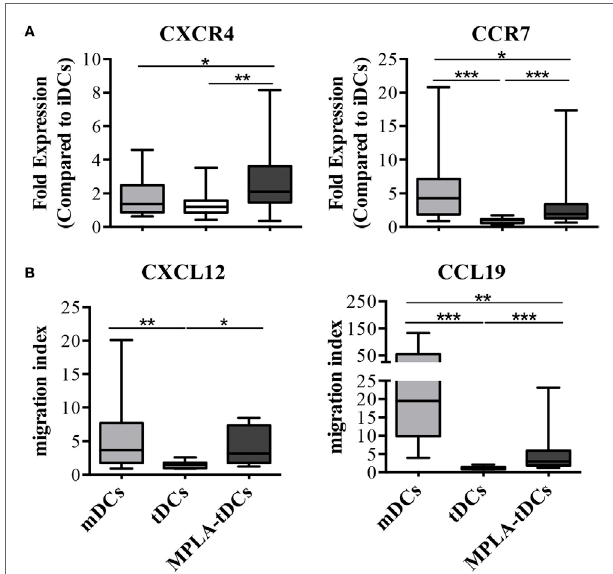
FigUre 3 | MPla-tDcs from rheumatoid arthritis patients display the capacity to migrate toward ccr7 and cXcr4 ligands . After 5 days of culture, the migratory capacity of MPLA-tDC ( dark gray ), tDCs ( white ) and mDCs ( light gray ) from rheumatoid arthritis (RA) patients was studied in vitro . (a) The percentage of CD11c + DCs expressing CXCR4 or CCR7 was determined by flow cytometry ( n = 15). Fold expression changes on receptor expression on mDCs, tDCs and MPLA-tDCs compared to untreated iDCs are shown. (B) Transwell assays were used to assess migration of DCs in response to 250 ng/ml of CXCL12 or CCL19 ( n = 12). Migration index indicates the quotient of cells that migrated toward a specific chemokine divided by cells that migrated toward medium alone. Box plots show median, 25- and 75%-quartile, minimum and maximum values, respectively. Wilcoxon signed-rank test was used to evaluate statistical differences between MPLA-tDCs, tDCs, and mDCs (* P < 0.05; ** P < 0.01; *** P <